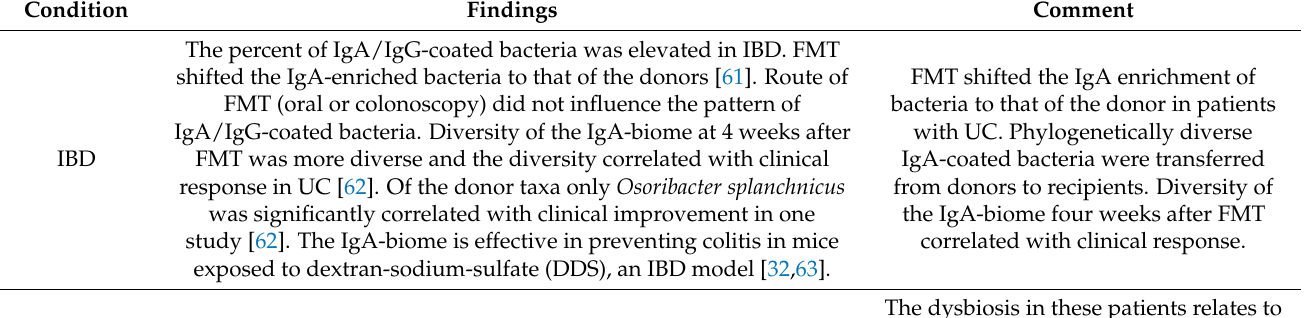
Table 3. IgA-biome in Conditions Associated with Dysbiosis Treated with Fecal Microbiota